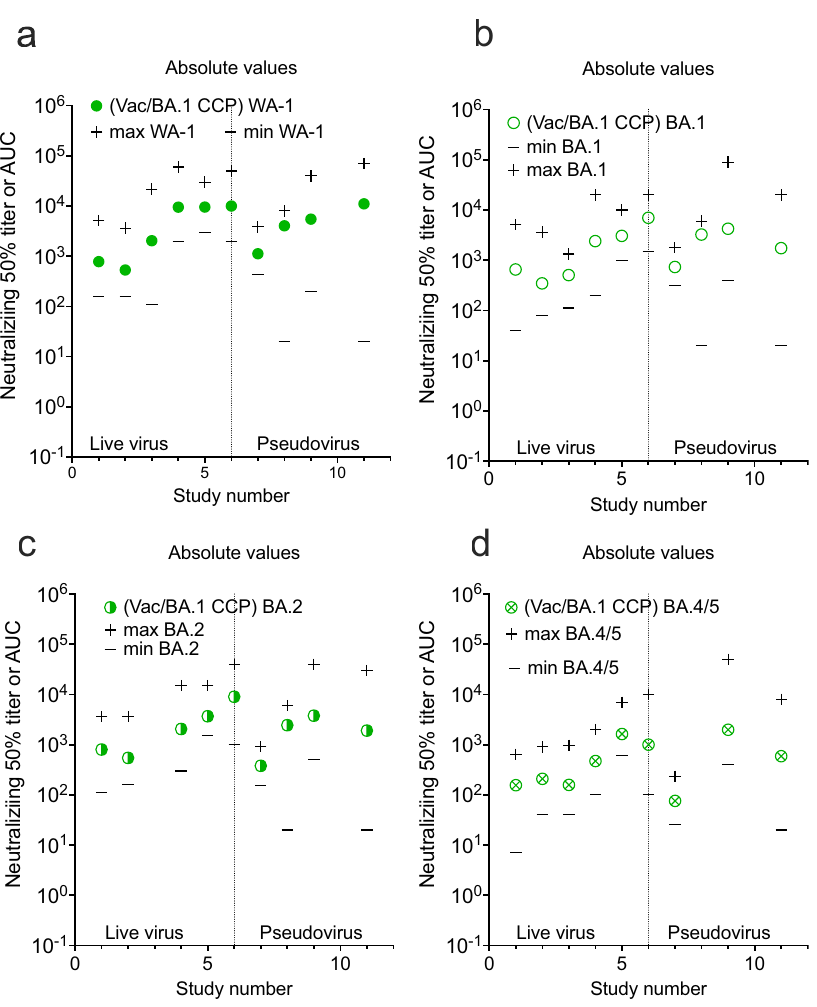
Fig. 8 | GMT 50 from each study with minimum and maximum dilution titer also shown. a post COVID-19-BA.1/Vac against WA-1, b post COVID-19-BA.1/Vac against Omicron BA.1, c post COVID-19 BA.1/Vac against Omicron BA.2, d post COVID-19 BA.1/Vac against BA.4/5. Source data are provided as a Source Data fi